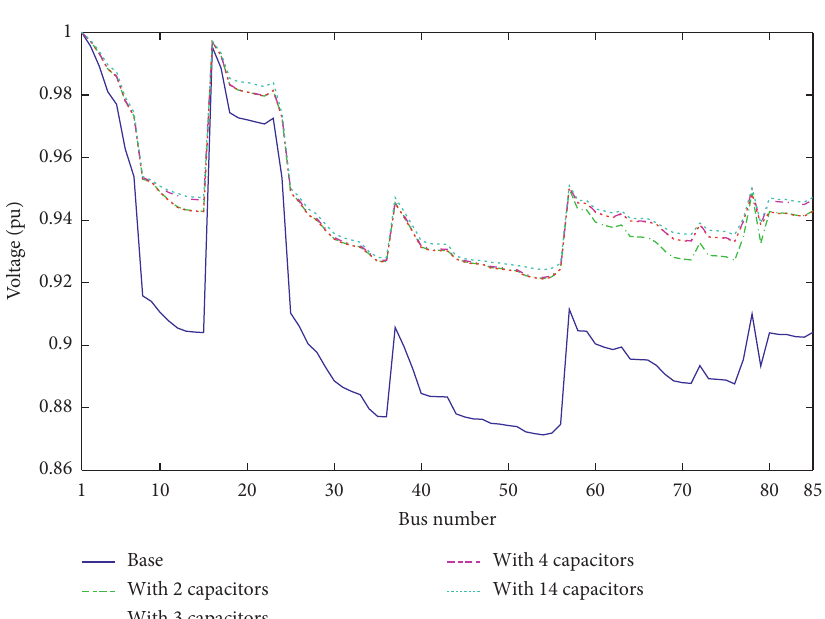
Figure 31: Voltage profile of 85-bus distribution system for different cases of capacitor